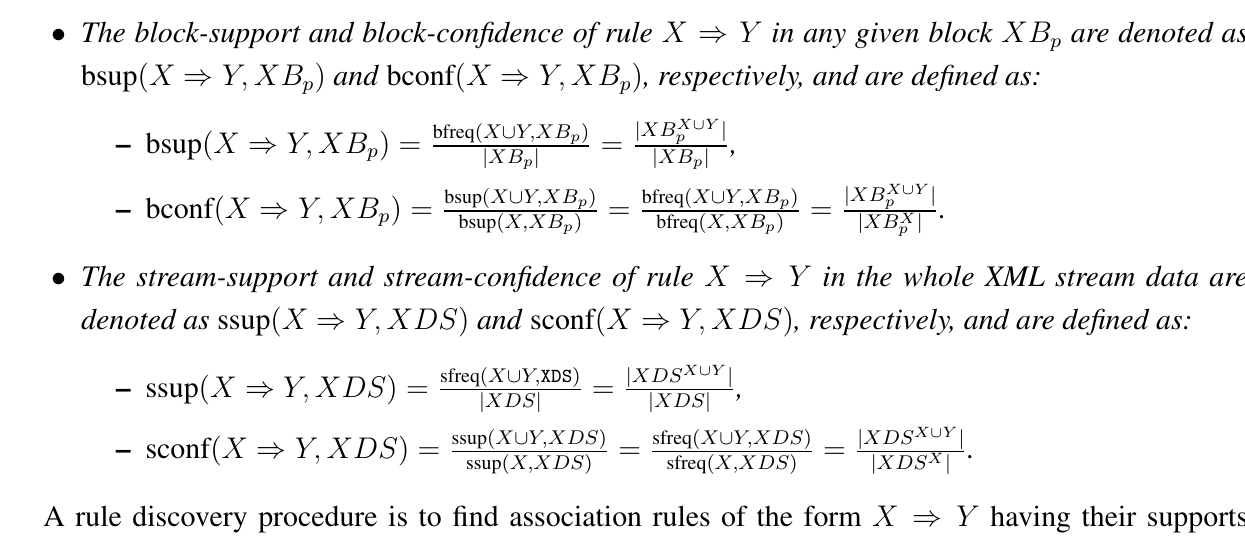
Figure 2. An example of XML stream data with two blocks, each having three transactions.